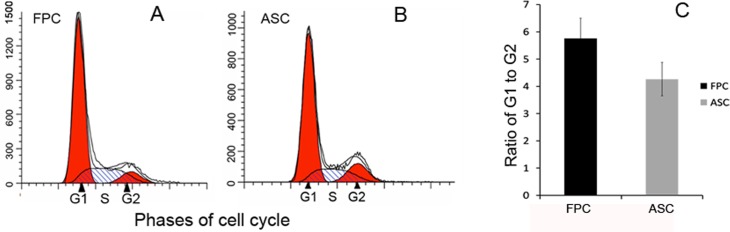
Cell cyclein the ASCs and the FPCs.Exponentially growing ASCs and FPCs were harvested for the cell cycle analysis using flow cytometry. The data were analyzed with ModFit LT Software to estimate the percentages of cells at G1, S, and G2/M phases. A: Cell cycle distribution of the FPCs. B: Cell cycle distribution of the ASCs. No distinct G2/M accumulation was observed in either of the cell lines. C: Ratio of the cell numbers at G1 to G2 phase. Note that there was no significant difference in cell cycle distribution between these two cell types (P>0. 05).